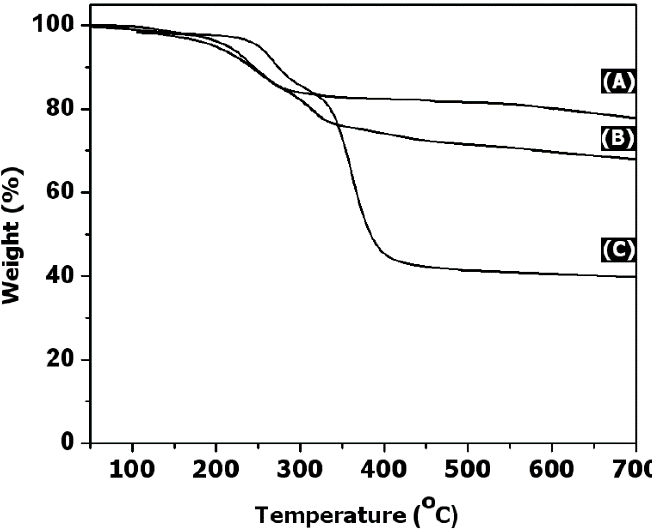
Figure 3. Thermogravimetric analysis (TGA) scans of ( A ) CdTe-OH, ( B ) CdTe-BTPT, and ( C ) PPEGMA- g -CdTe.